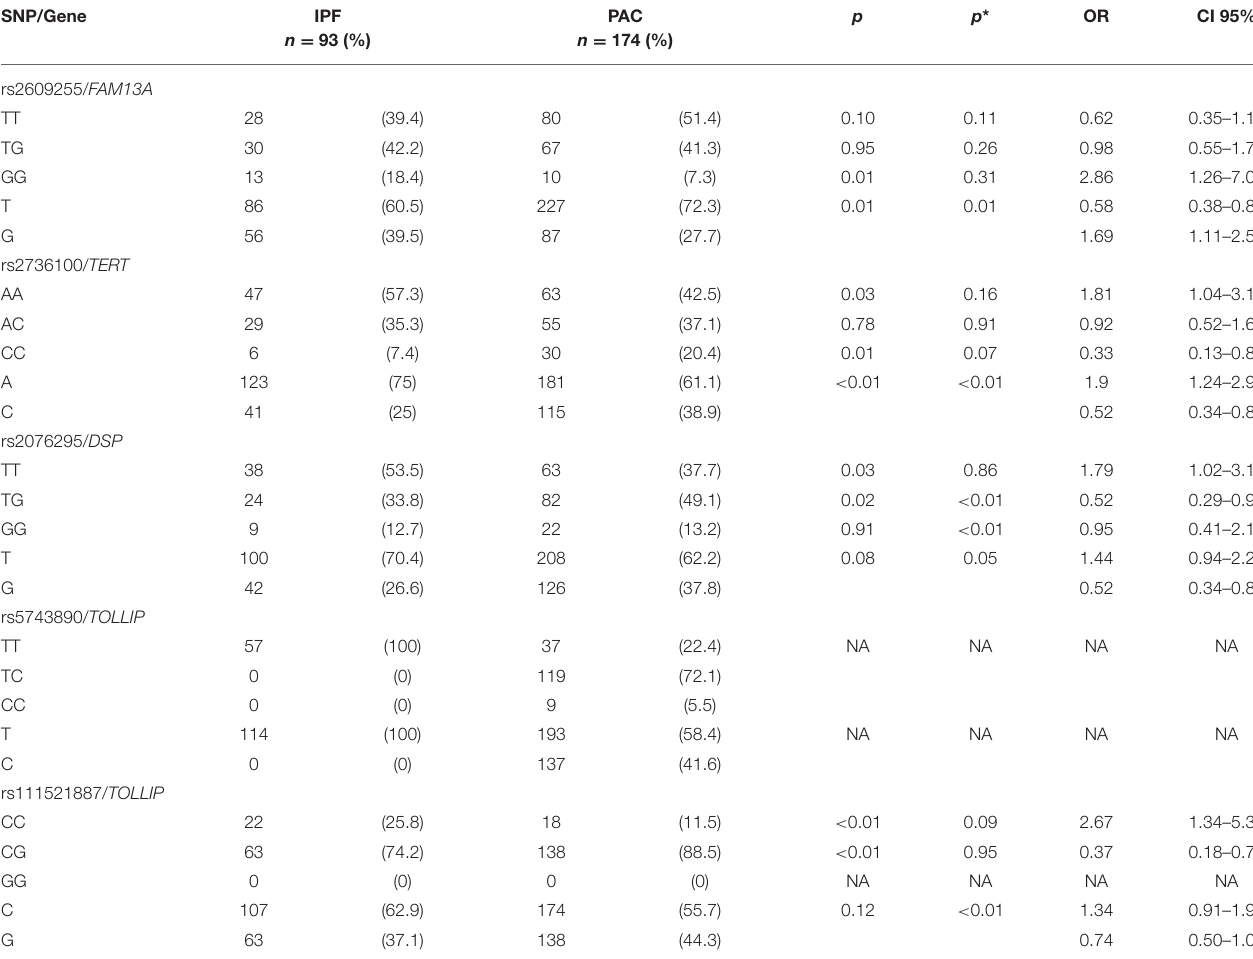
TABLE 3 | Allele and genotype frequencies of IPF vs. PAC